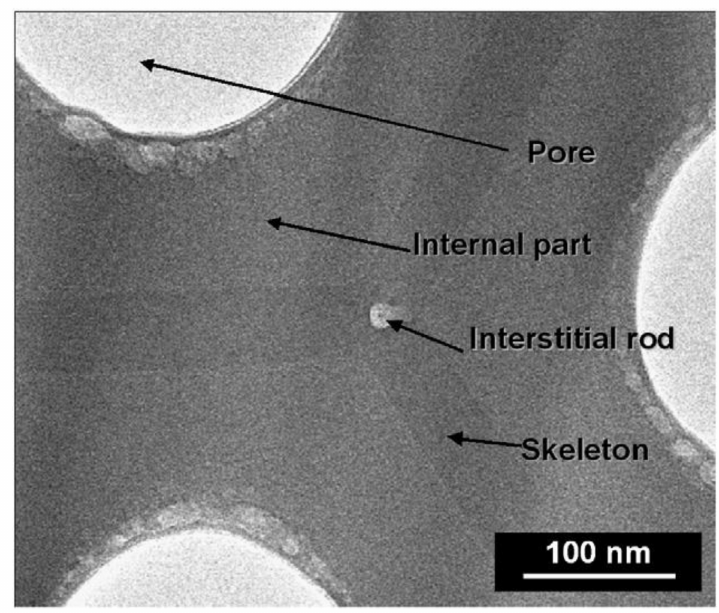
Figure 6. TEM plane view of AAO-PA, prepared in 8 wt.% phosphoric acid, at constant applied voltage of 185 V for 4 h and − 1.5 ◦ C, showing the different parts of the pore wall (i.e., the outer pore wall, cell-boundary band, and interstitial rod). Reprinted with permission from Ref. [98]. Copyright 2009 Elsevier